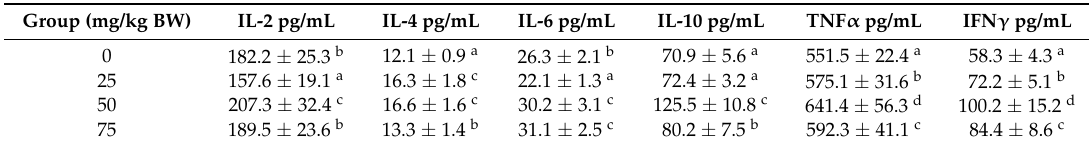
Table 5. Effect of oral administration with the SCP on Concanavalin A (Con A)-induced cytokines production by lymphocyte of C57BL/6 mice.